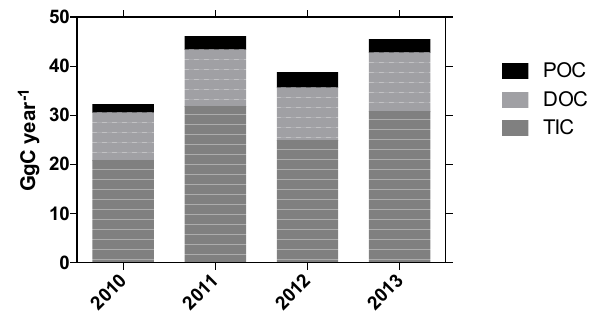
Figure 3. Total carbon inputs in the form of particulate organic car- bon (POC), dissolved organic carbon (DOC) and total inorganic carbon (TIC) from the Nam Theun watershed to the Nam Theun 2 Reservoir for 4 distinct years after reservoir